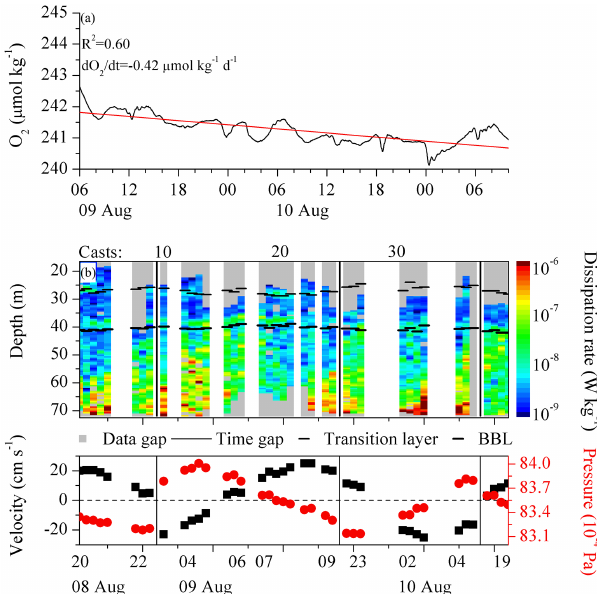
Figure 5. BBL dissolved oxygen time series and turbulence con- tour. (a) Near-seafloor BBL O 2 concentration changes over the ob- servational period from the POZ lander. Red line indicates the es- timated apparent linear O 2 loss. ( b , top) Turbulence contour plot of all MSS90 casts together with the temperature layers. Thin and thick dashed lines represent the transition layer to the interior layer interface and the interior layer to the BBL interface, respectively. Grey spots indicate data missing due to uncompleted profiles (casts 16–23), unsuccessful profiles (cast 36), or flagged as bad based on spikes, collisions and suspected contamination due to ship activity. The vertical black lines indicate the transition (time gaps) between consecutive profile ensembles. ( b , bottom) Background information on bottom current and hydrostatic pressure during the casts. Both velocity and pressure data were collected by the deployed POZ lan- der. Note that as a result of the time gaps between the consecutive MSS90 casts (see Fig. 3a) the timescale is not